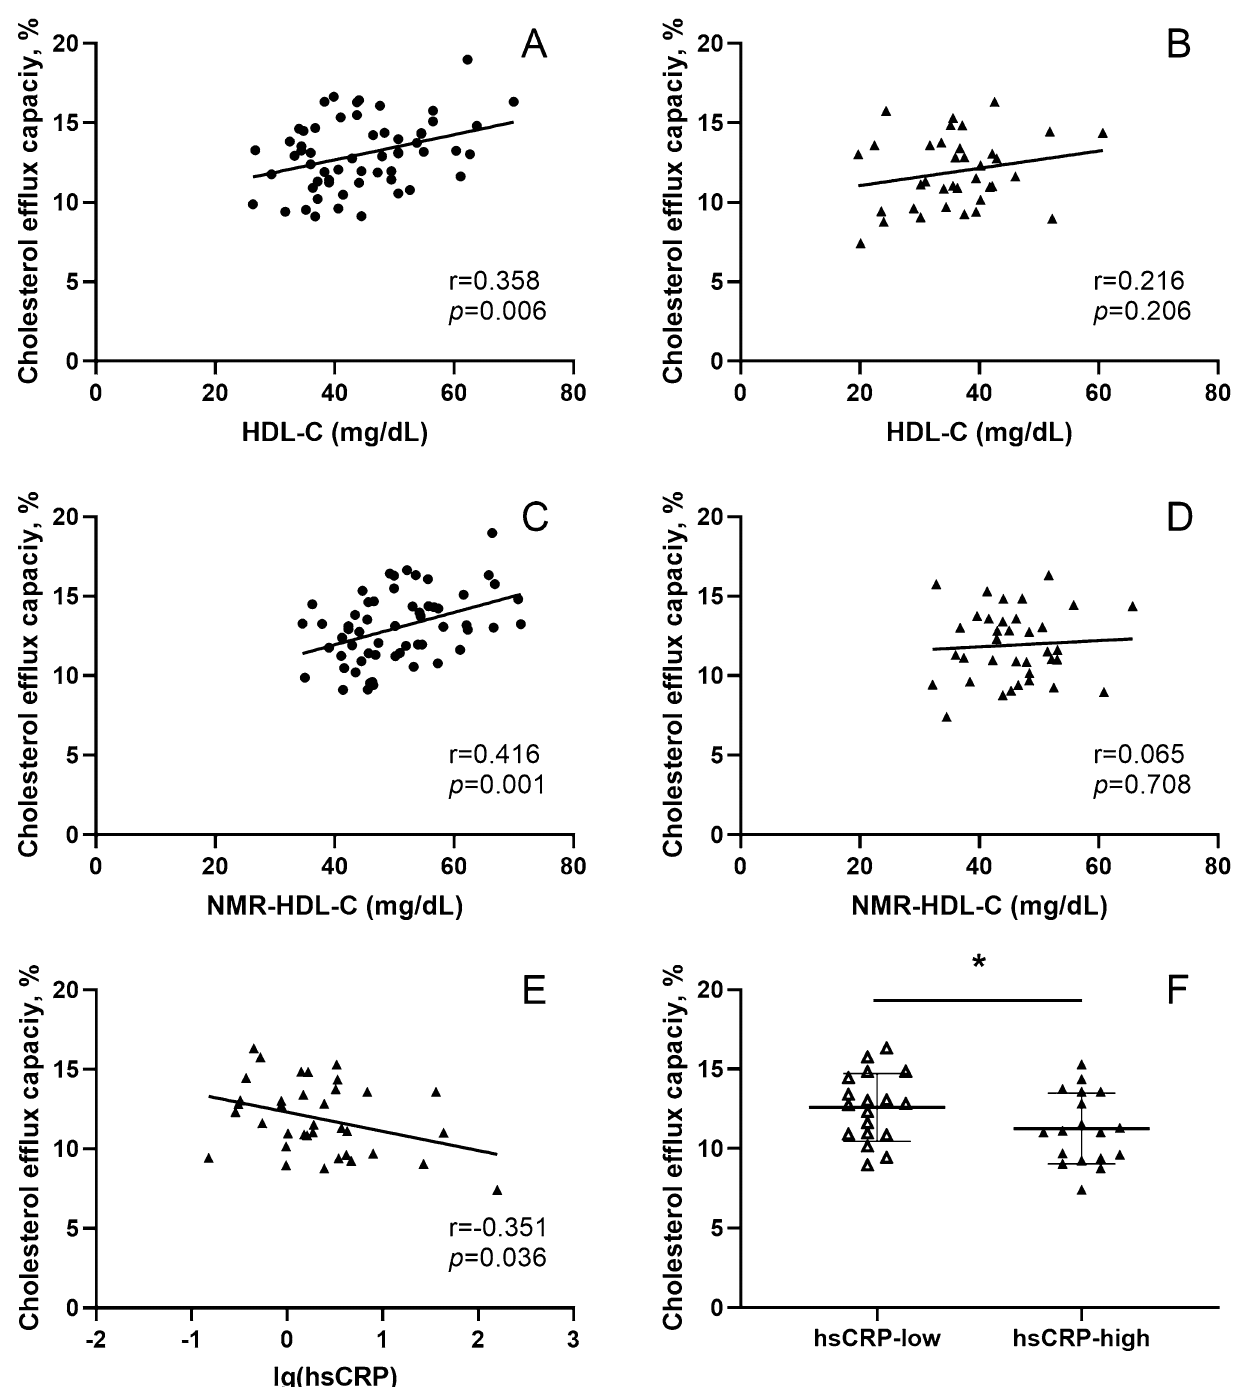
Figure 2. Correlation between CEC and HDL-C in ( A ) non-CAD controls and ( B ) CAD patients. Correlation between CEC and NMR-HDL-C in ( C ) non-CAD controls and ( D ) CAD patients. ( E ) Correlation between hsCRP levels (log-transformed) and CEC in CAD patients (n = 36); ( F ) Comparison of CEC between hsCRP- low CAD patients (hsCRP < 1.75 mg/L, n = 18) and hsCRP-high CAD patients (hsCRP ≥ 1.75 mg/L, n = 18). CEC, cholesterol efflux capacity; CAD, coronary artery disease; NMR-HDL-C, NMR measured high-density lipoprotein cholesterol; hsCRP, high-sensitivity C-reactive protein; CEC, cholesterol efflux capacity; CAD, coronary artery disease; * p < 0.05. Statistical analysis was performed using SPSS version 25.0 (IBM, USA, https:// www. ibm. com/ analy tics/ spss- stati stics- softw are) and the figure was made by GraphPad Prism version 8.0 (GraphPad Prism Inc, USA, https:// www. graph pad. com/ scien tific- softw are/